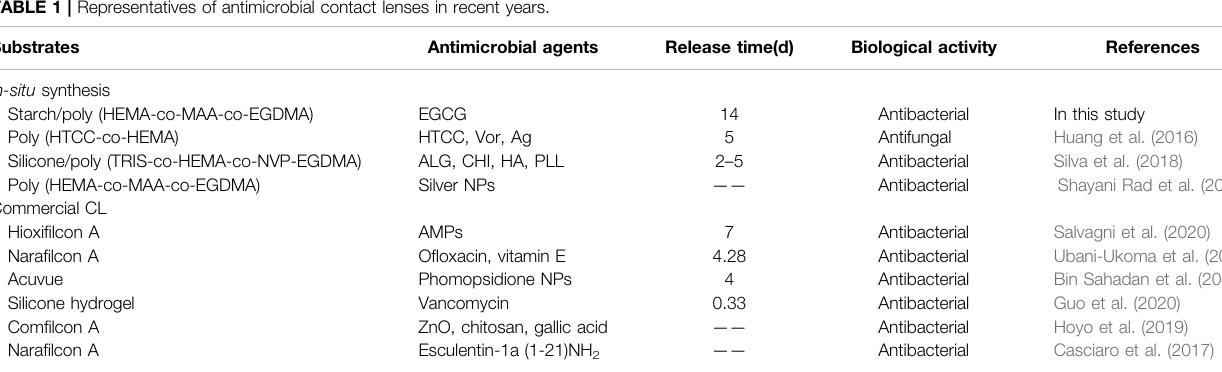
TABLE 1 | Representatives of antimicrobial contact lenses in recent years.